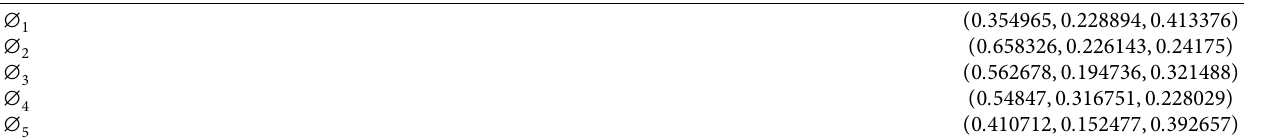
Table 6: SVN Acz-A1s geometric AOSVNAWG